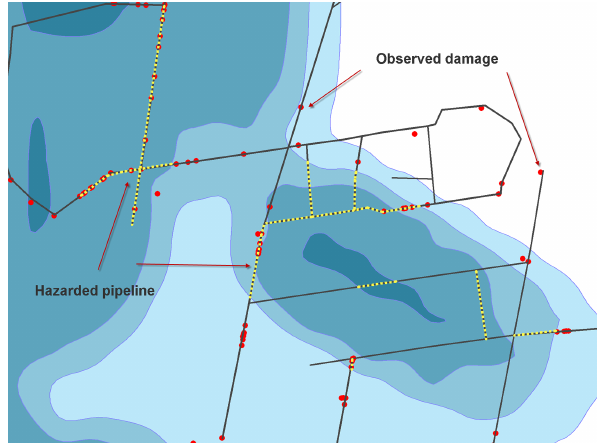
Figure 2. Hazard evaluation of water pipeline with point method (yellow dotted line: endangered part of the pipeline, red dot: ob- served damage).